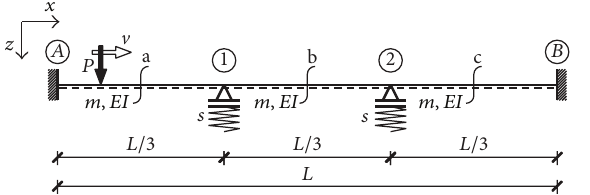
Figure 23: Three-span continuous uniform beam with elastic mid- span supports loaded with moving force.